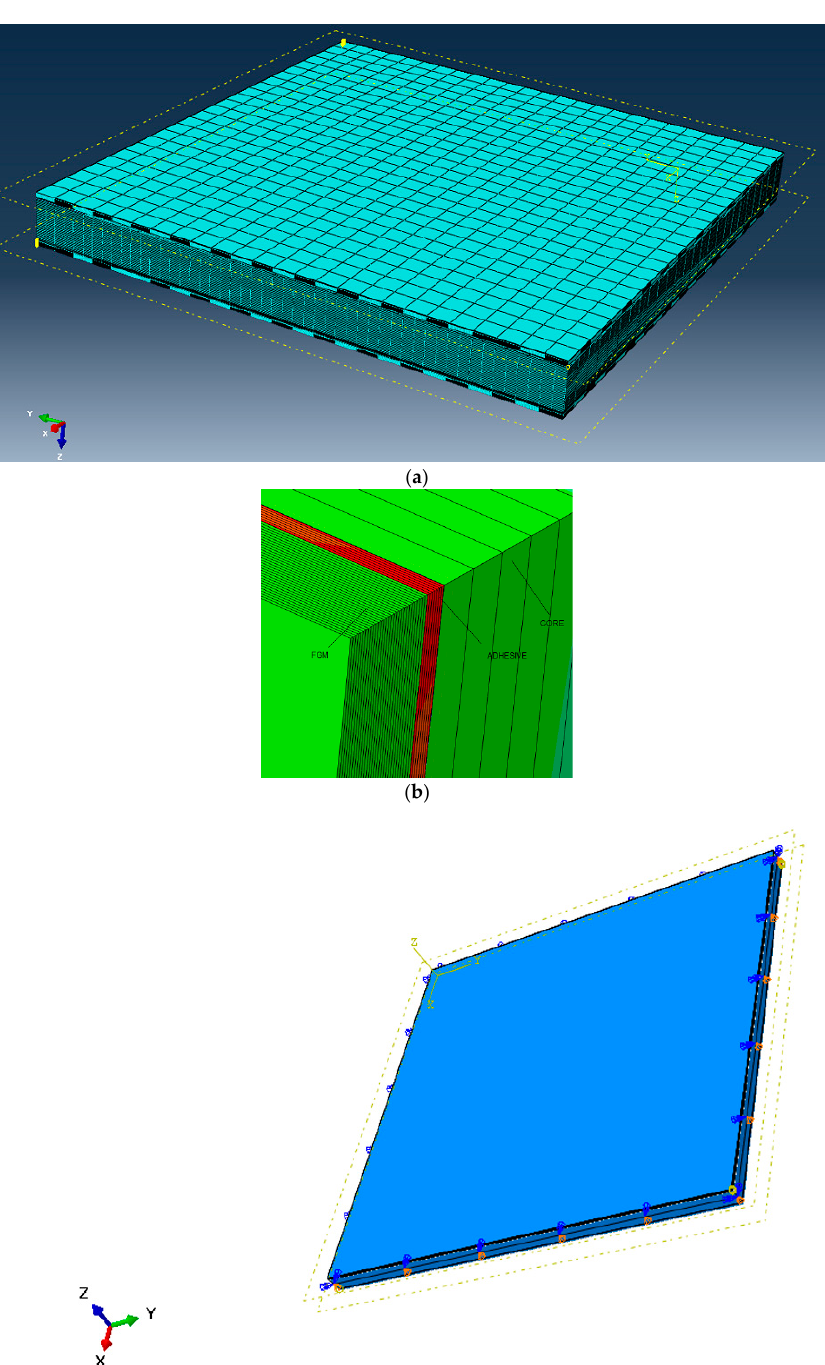
Figure 2. Finite element model of the sandwiched plate. ( a ) The finite element model of the sand- wiched plate resting on simply supported edges. ( b ) Meshed model of the sandwiched plate showing the subdivisions in the FGM cover plates. ( c ) Simply supported boundary conditions are imposed on four